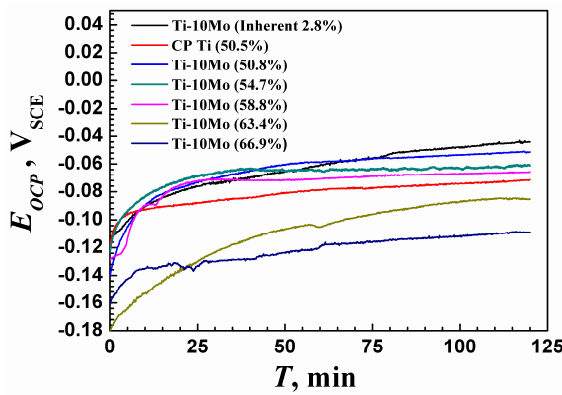
Figure 7. Open-circuit potential as a function of time for different Ti alloy samples in naturally aerated phosphate-buffered saline solution at (37 ± 0.5) °C.